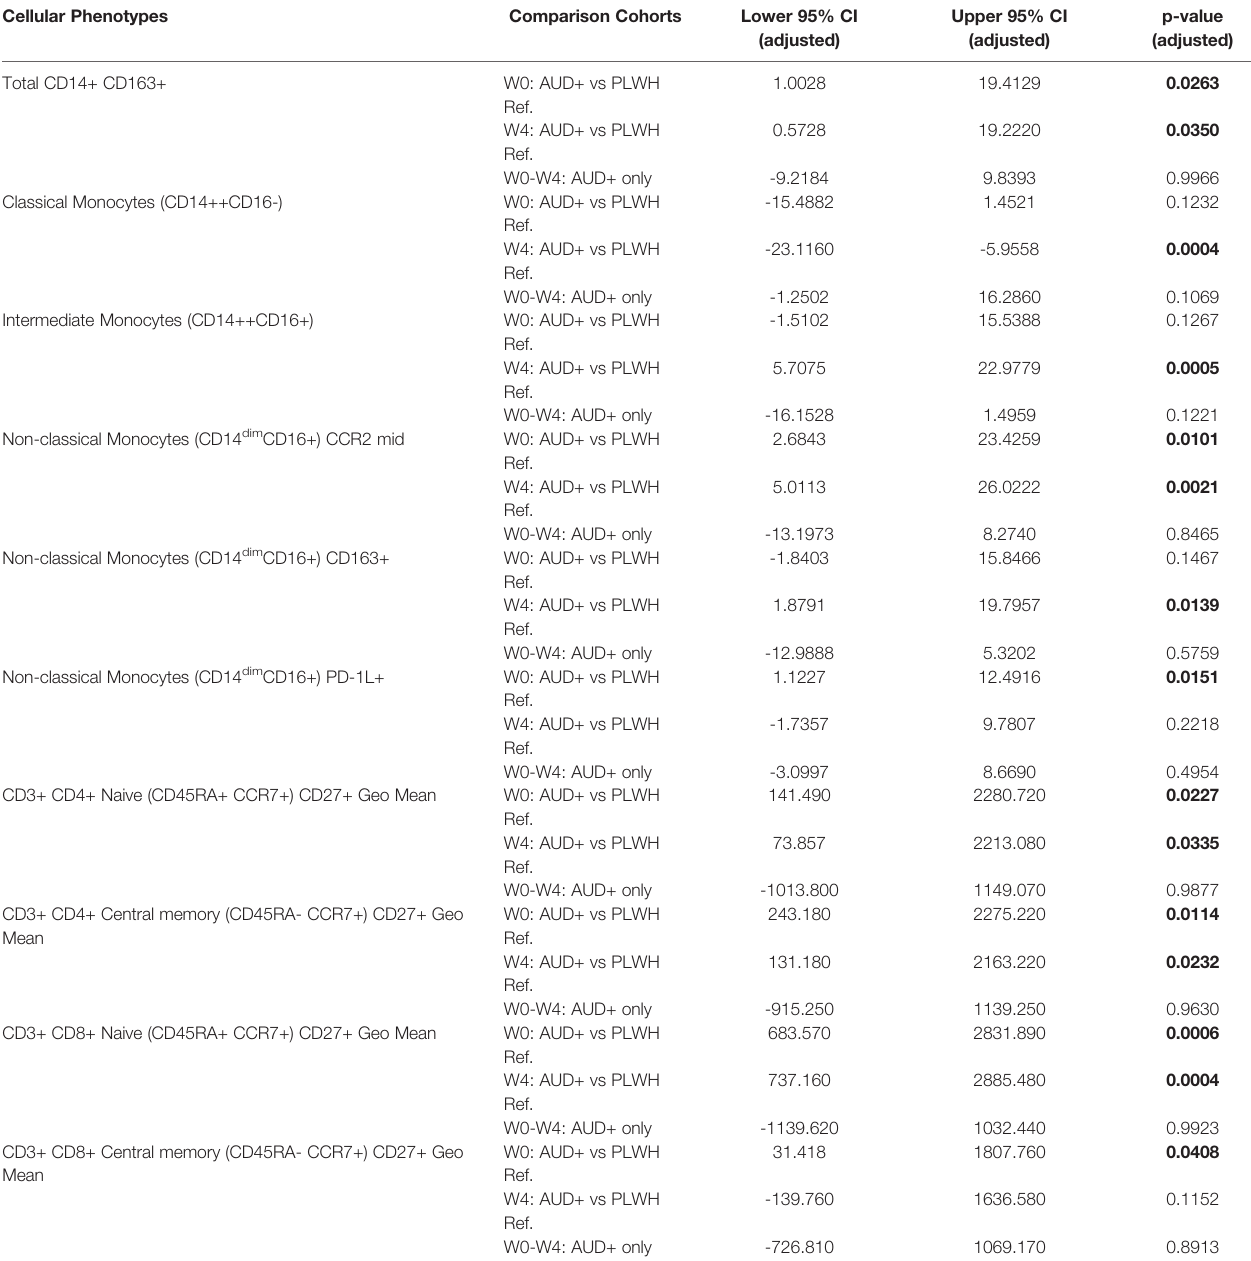
TABLE 3 | Signi fi cant differences in cellular phenotypes between PLWH with and without AUD. Cellular Phenotypes Comparison